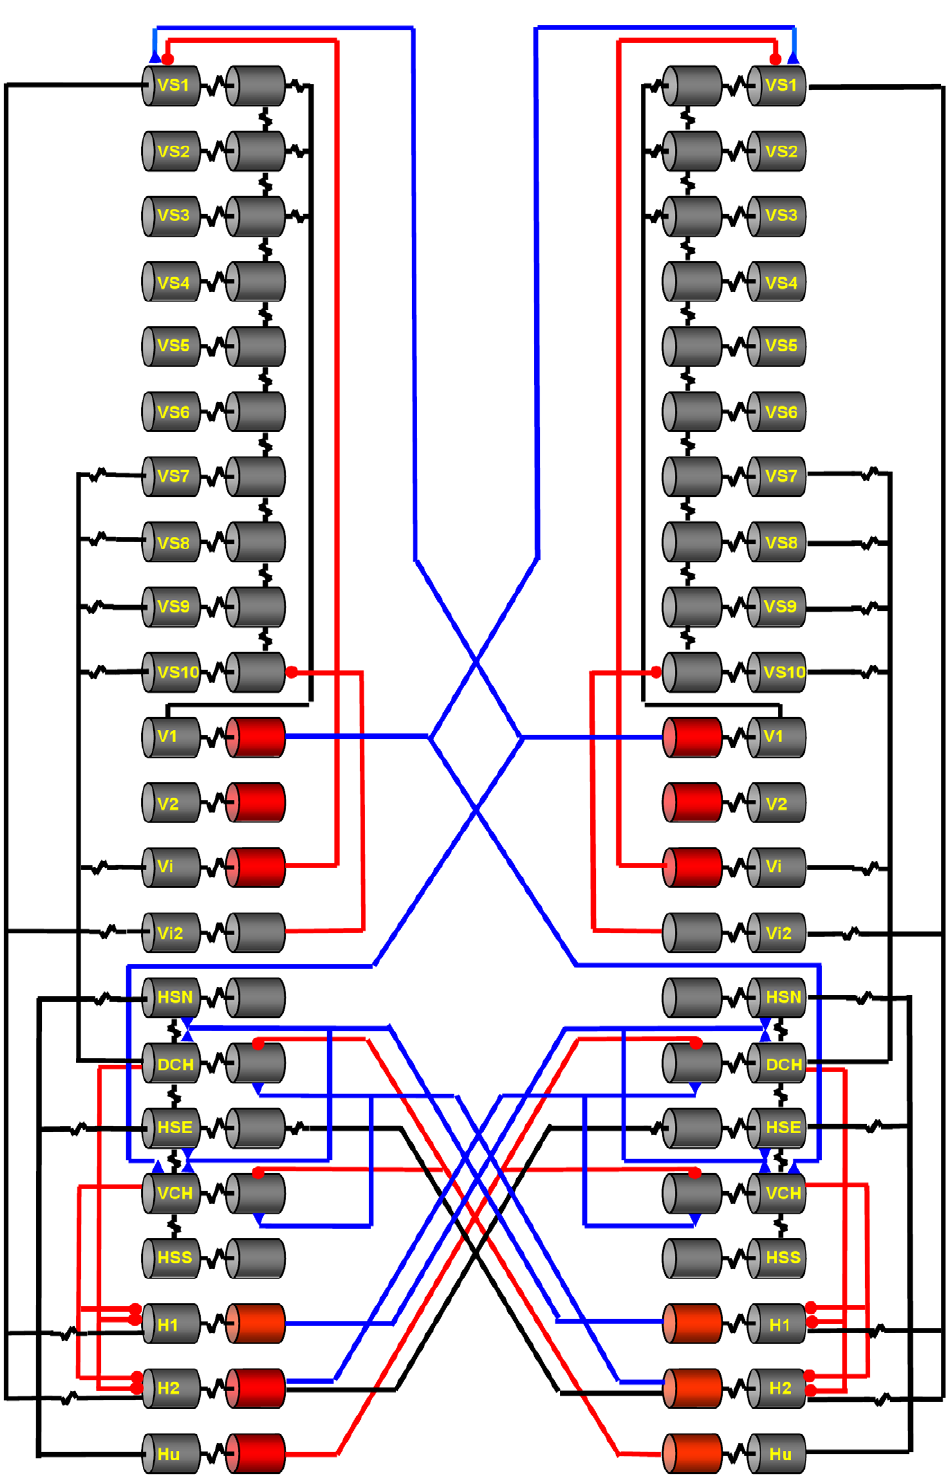
Figure 1. Neural circuit of the lobula plate. For each hemisphere, 22 different lobula plate tangential cells are modeled most of them receiving retinotopic input from local motion detectors (not shown). Each cell is represented by two compartments, one dendritic and one axonal. Compartments are either modeled as passive (grey) or as active, action potential generating elements (red). The connections between the different cells are shown according to their type: electrical synapses, i.e. gap junctions in black, excitatory synapses in blue and inhibitory synapses in red.